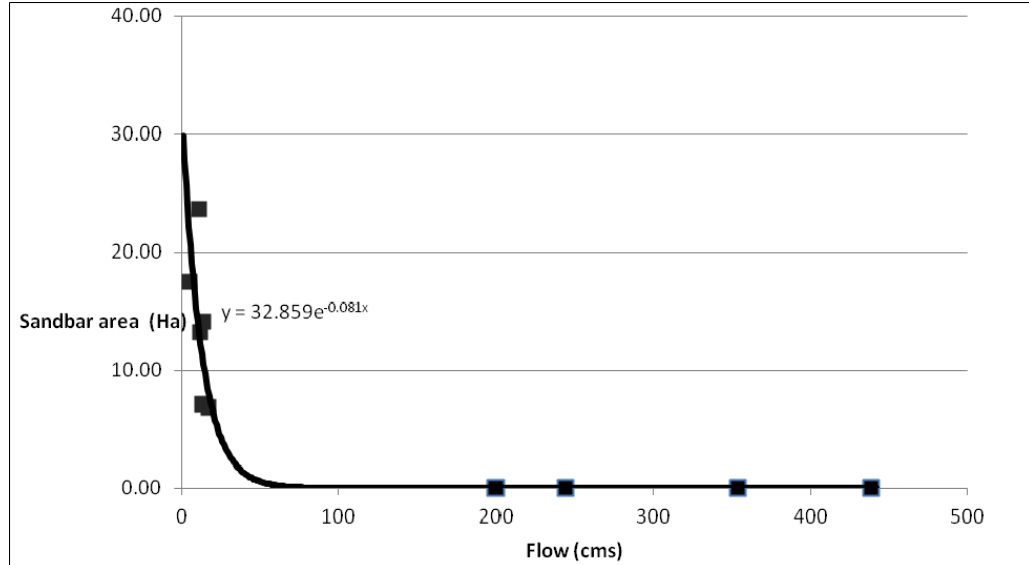
Figure 2. Sandbar emergence from stream flow in the lower Minnesota River. The area of sandbar exposed in the study reach of the river ( y -axis) at different stream discharge points indicated on the x -axis. This analysis helped to determine the incipient point of sandbar exposure, which ranged from 57 to 143 m 3 /s. To the lower right at flows >100 m 3 /s, the sandbars are submerged, while they become nearly fully exposed at about 30 m 3 /s. The bankfull flow in this reach is approximately 567 m 3 /s.